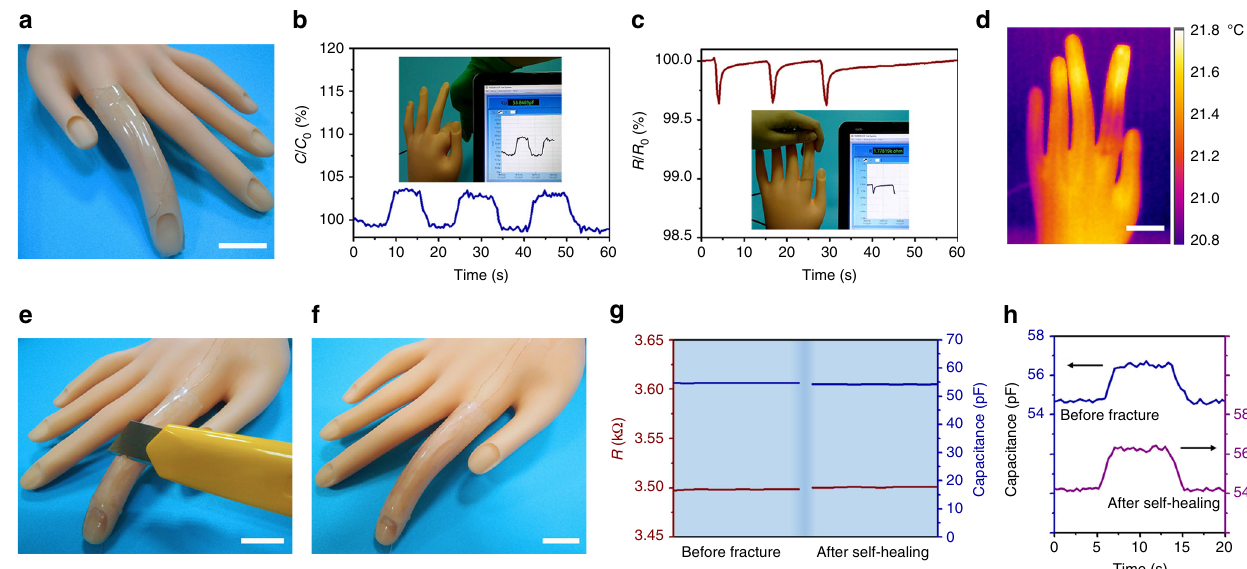
Fig. 4 Applications in strain and temperature sensing and self-healability of the biomimetic skin. a A photo of the biomimetic skin attached to a prosthetic fi nger with the assistance of VHB tapes. b Capacitive signals monitor the fi nger ’ s movements. The inset photo is derived from Supplementary Movie 2. c Resistive signals when a person ’ s hand contacts the prosthetic fi nger. The inset photo is derived from Supplementary Movie 3. d An infrared image of the prosthetic hand after the removal of the person ’ s hand. e A photo of a biomimetic skin whose hydrogel layer is cut into half. f A photo of the biomimetic skin after self-healing. g The resistance and capacitance of the biomimetic skin before fracture and after self-healing. h The capacitance changes of the biomimetic skin before fracture and after self-healing when it is applied to detect a prosthetic fi nger ’ s bending – straightening movement (the capacitance increases when the fi nger bends and decreases when it straightens). (Scale bar: 2